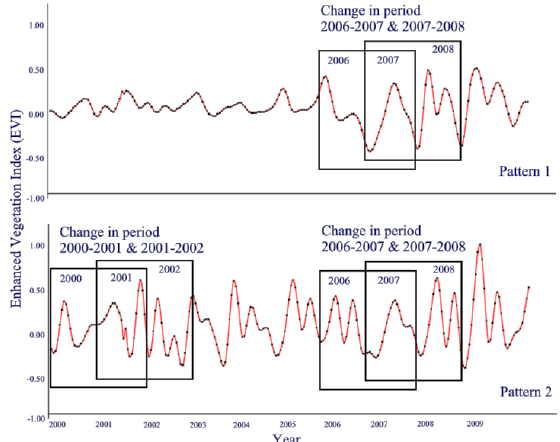
Figure 7. Detection of seasonal changes (temporary changes) which occurred for several times, contributed to the